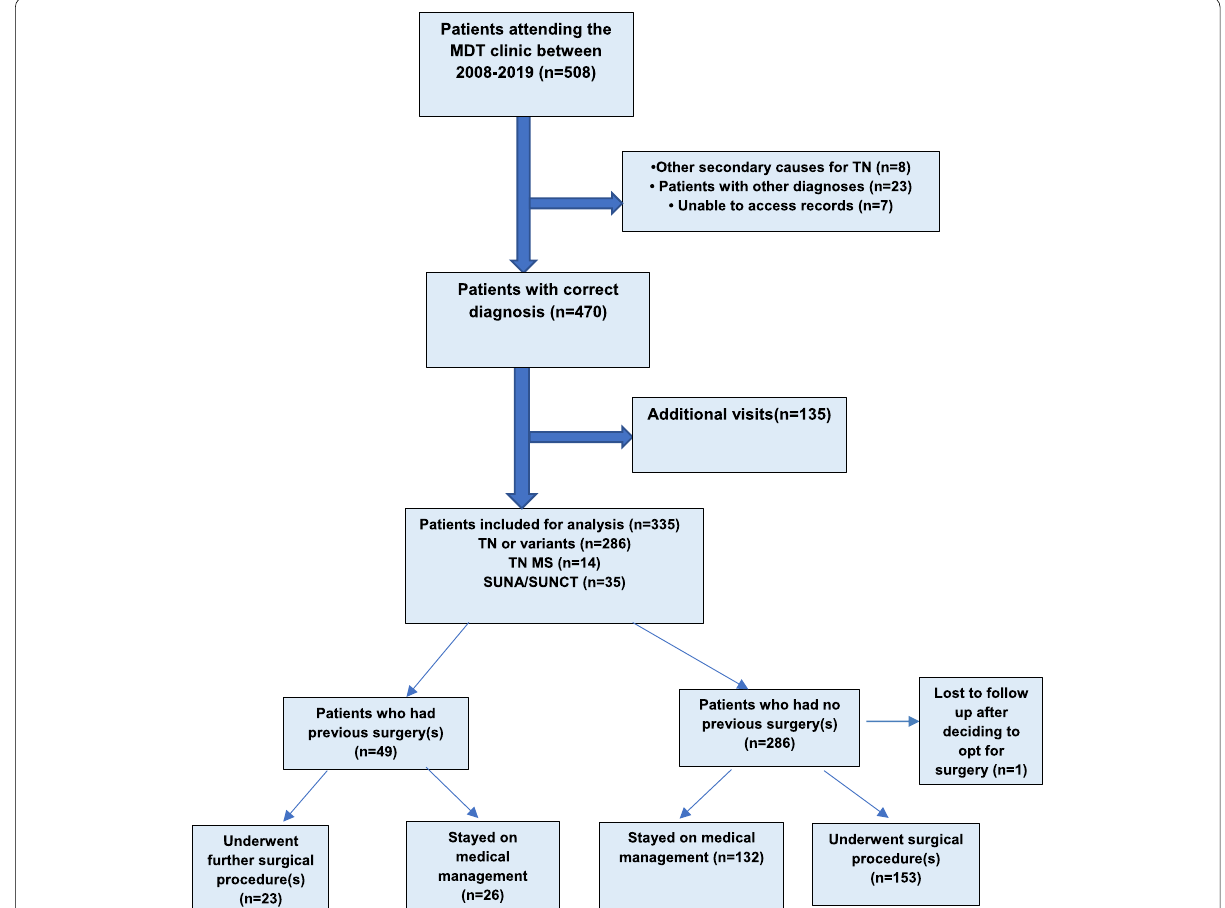
Fig. 1 Flow diagram of patient selection. Figure legends: TN neuralgiform pain with autonomic symptoms; SUNCT